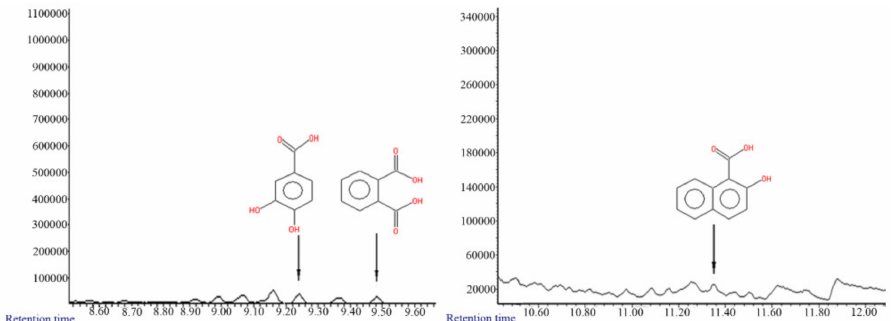
Figure 5. Gas chromatographic analysis of anthracene metabolites—protocatechuic acid, o-phtalic acid, and 2-hydroxy-1naphthoic